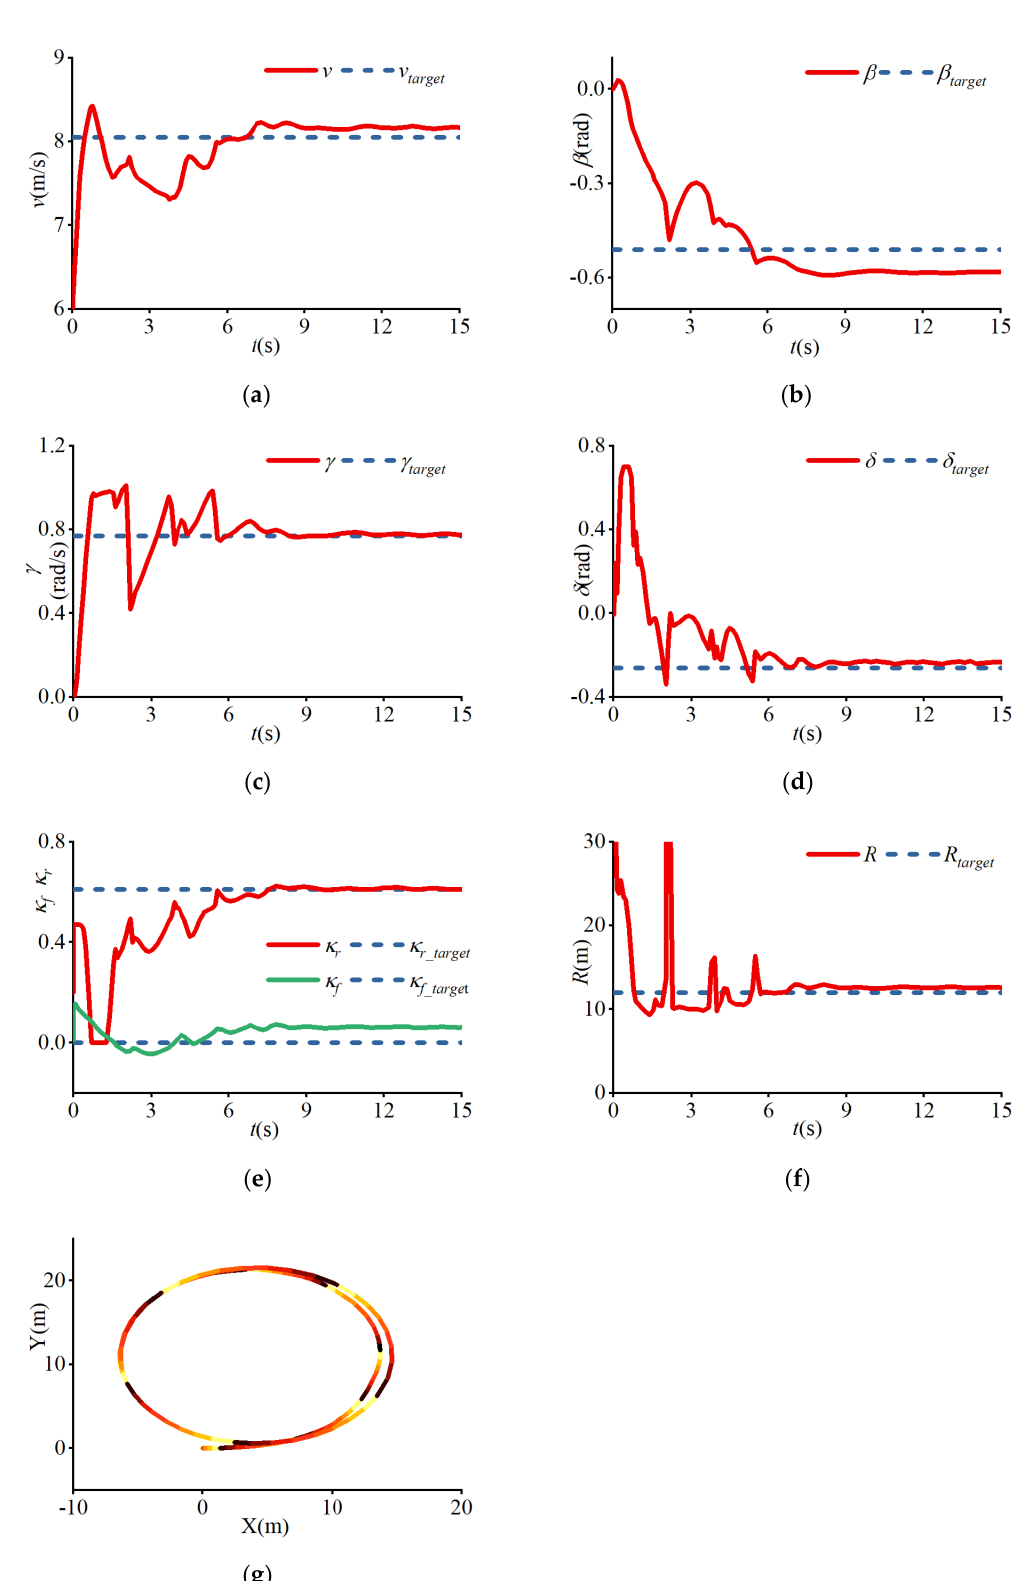
Figure 6. The simulation result with the 6 m/s original velocity and the target group (c): ( a ) the velocity; ( b ) the sideslip angle; ( c ) the yaw rate; ( d ) the steering angle; ( e ) the TYDEX longitudinal slip ratios of the front and rear tires; ( f ) the radius of the motion curve; ( g ) the motion curve of the vehicle. All continuous lines suggest the simulation results, while the dashed lines suggest the targets.